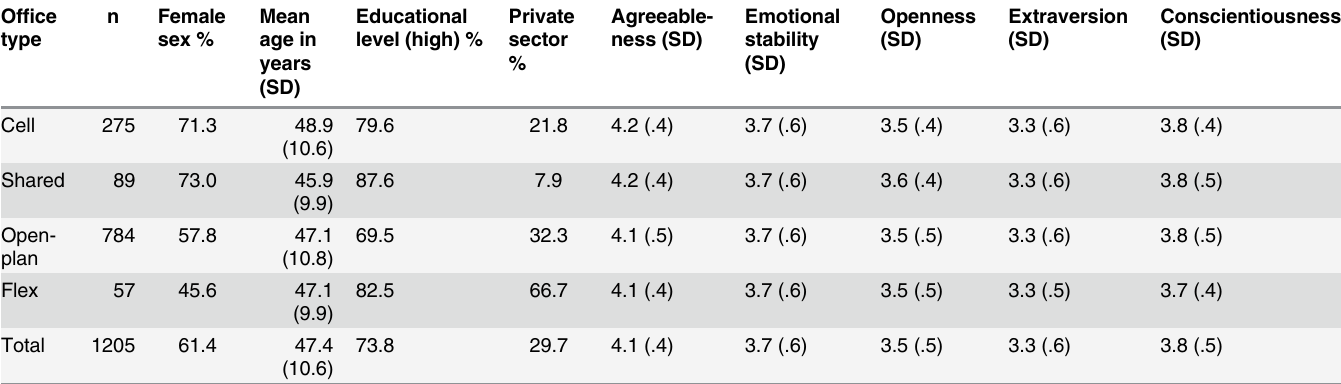
Table 1. Description of the respondents by office type ( N =